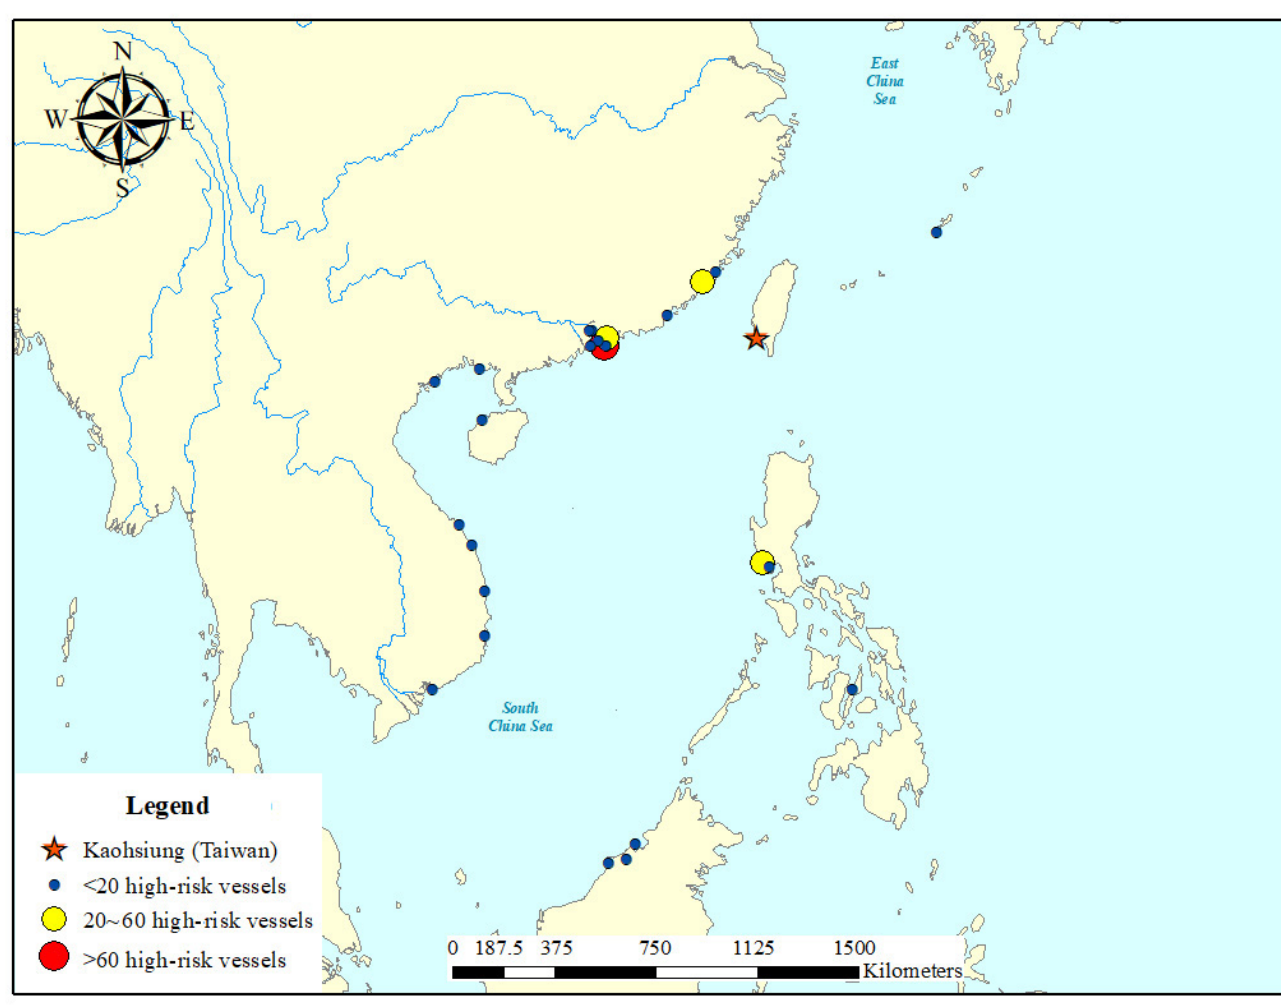
Figure 3. Location of the donor ports of high-risk vessels that visited the port of Kaohsiung. The blue, yellow, and red solid circles represent the donor ports where the high-risk vessels originated from. Each color corresponds to the number of vessels <20, 20–60, and >60, respectively. Table 5. The donor ports of high-risk vessels that visited the ports of Kaohsiung and Riga.